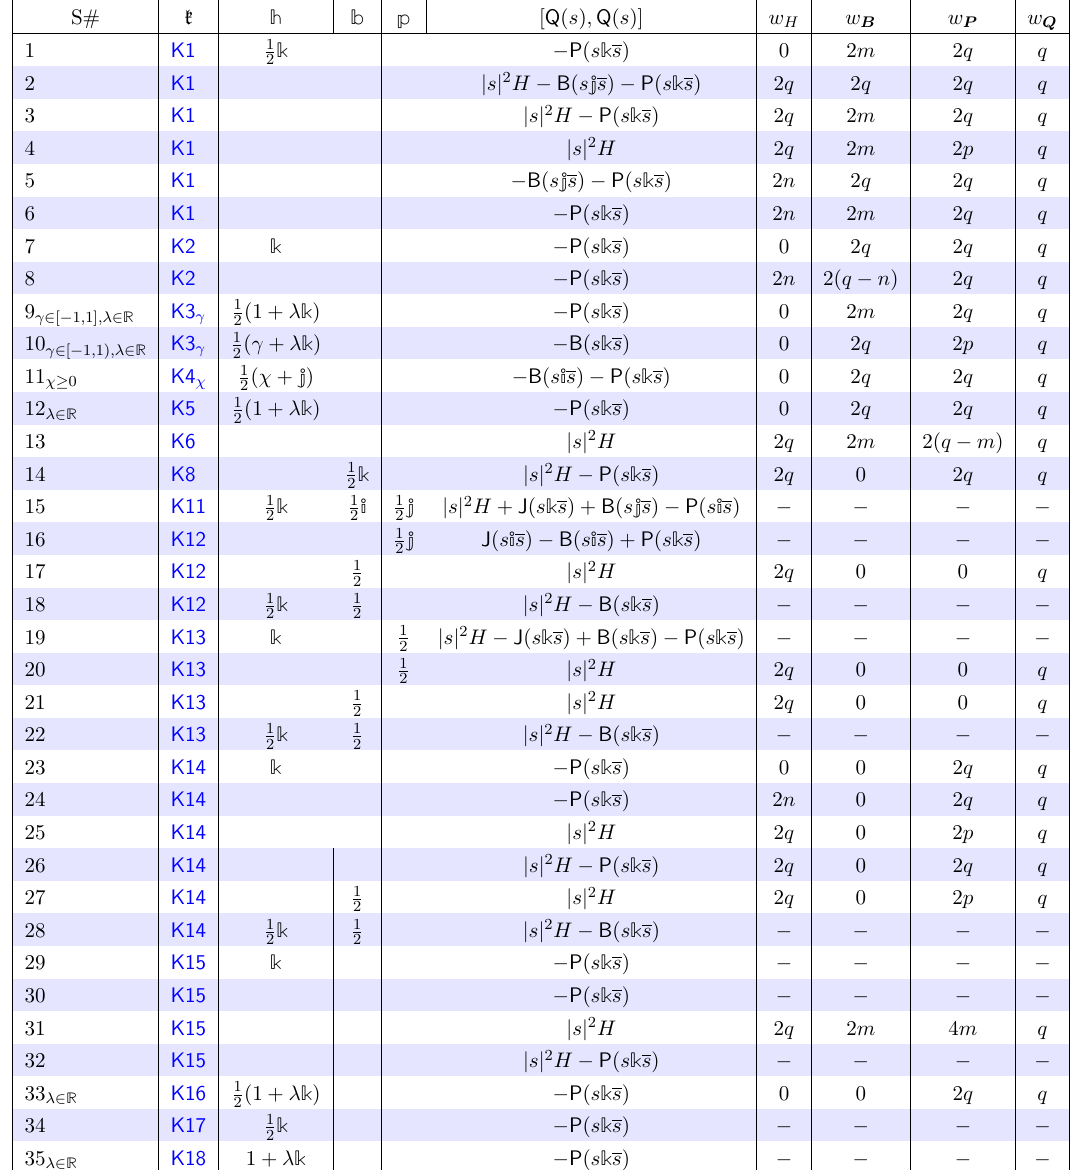
Table 4 . Kinematical Lie superalgebras (with [ Q ; Q ] 6 =